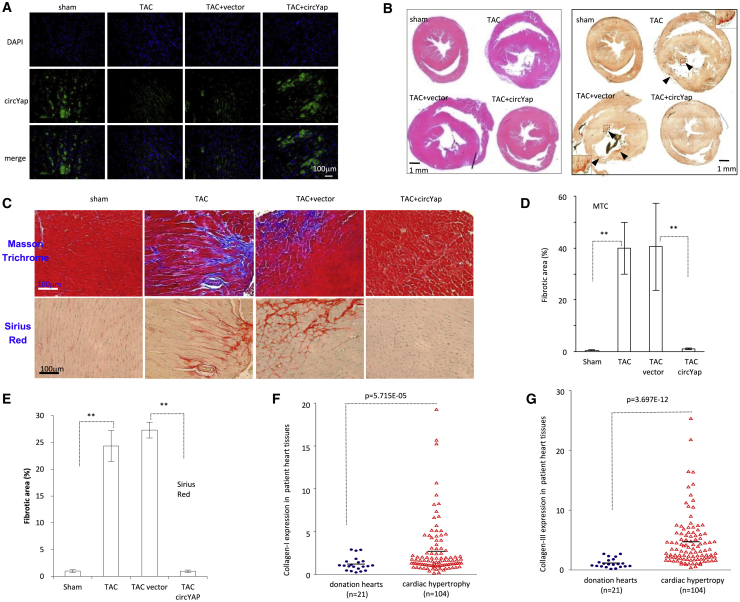
The Effects of circYap on Fibrosis in Pressure-Overload Hearts(A) Representative photographs of fluorescence in situ hybridization (FISH) staining to confirm the successful circYap plasmid delivery into the mouse hearts. (B) Representative photographs of H&E-staining and Sirius red staining showed the heart sections of sham, TAC, TAC + vector, and TAC + circYap mice. (C) Representative photographs of Masson trichrome and Sirius red staining, showing that ectopic circYap delivery prevented the elevation of fibrosis in the TAC mouse hearts. (D and E) Quantitation of Masson trichrome (D) and Sirius red (E) staining. n = 3. ∗∗p < 0.01. (F and G) Real-time PCR in patient hearts and normal heart donations showed that patients produced higher levels of collagen-I (F) and collagen-III (G) than the normal hearts.